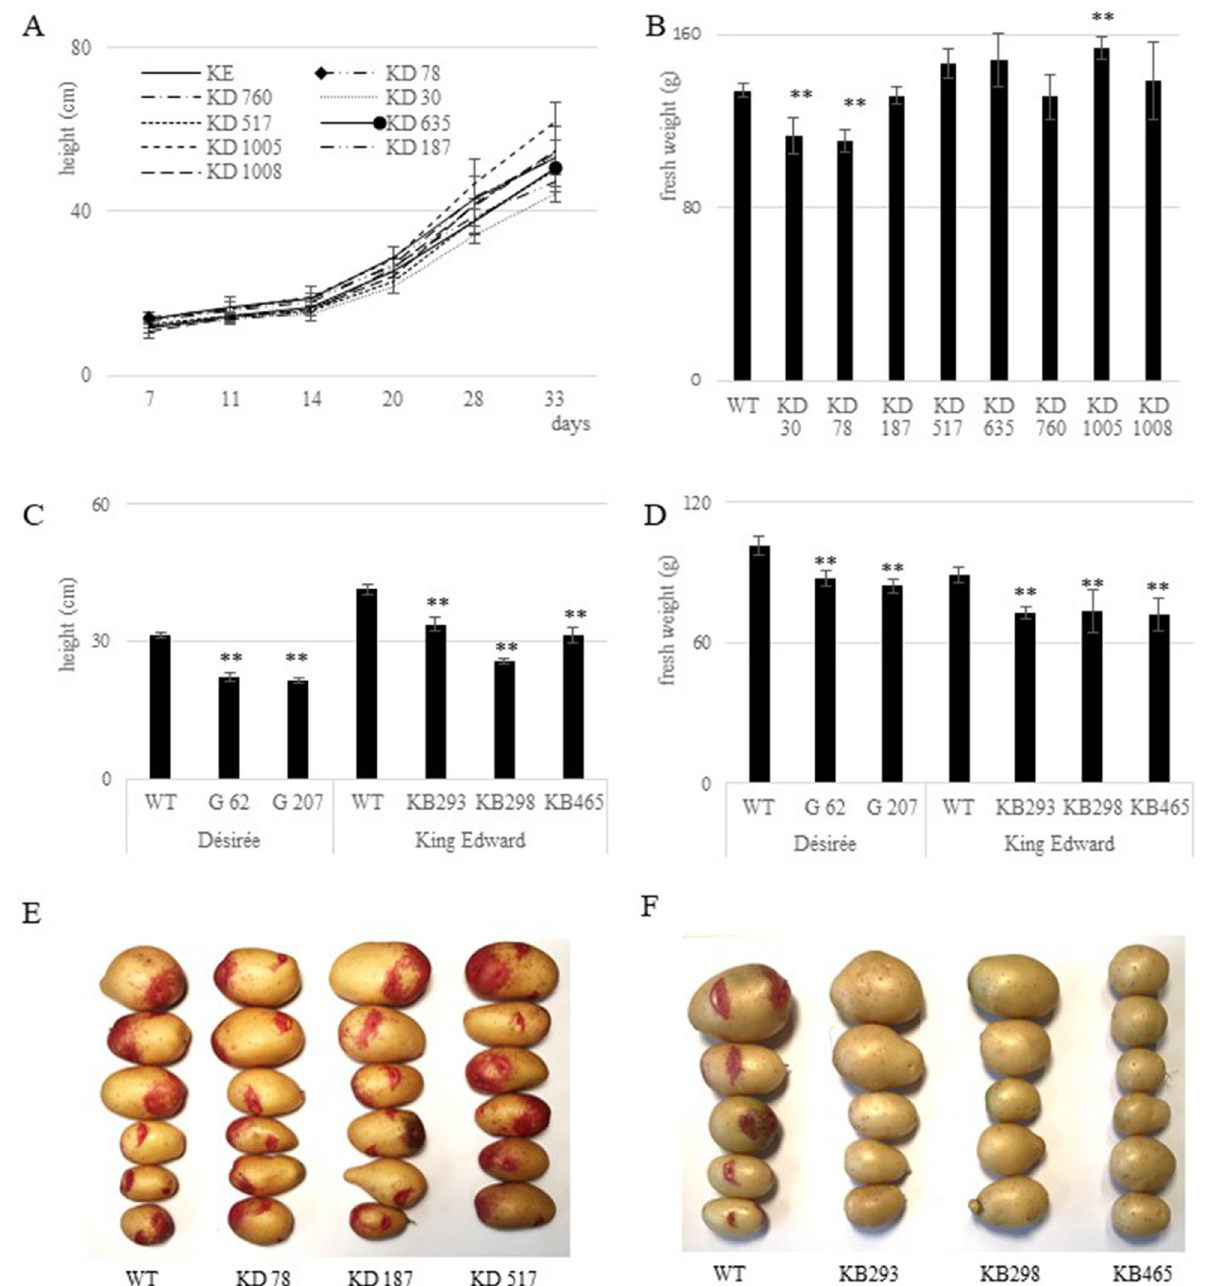
Figure 3. Growth phenotypes of Stdmr6-1 and Stdmr6-2 mutant lines. ( A) Growth curve of wild type and Stdmr-1 mutant lines. ( B ) Fresh weight of 5-week-old wild type and Stdmr6-1 mutant lines. ( C ) Plant height of wild type and Stdmr6-2 mutant lines. ( D ) Fresh weight of 5-weeks-old wild type and Stdmr6-2 mutant lines. ( E ) Tuber morphology of King Edward wild type and its Stdmr6-1 mutant lines. ( F ) Tuber morphology of King Edward wild type and Stdmr6-2 mutant lines. Error bars show standard variation and asterisks denote values significantly different from that of the wild type, student t-test (**: p < 0.01, n = 4 for King Edward and n = 6 for